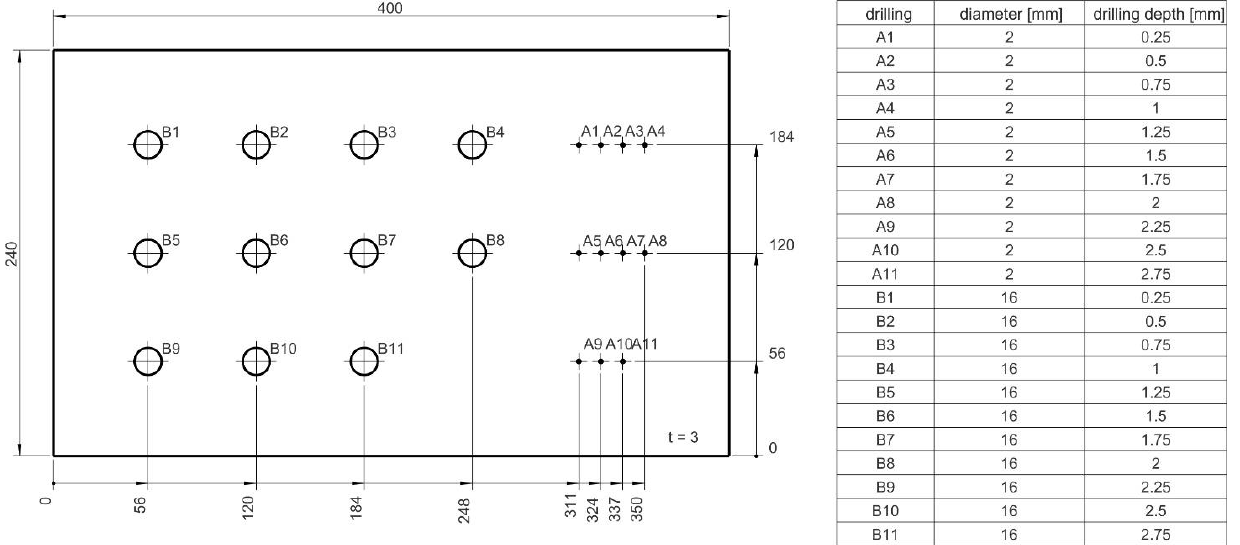
Figure 1. Geometry of HFB test specimens with drilled holes of diameter Ø 16 mm and Ø 2 mm.